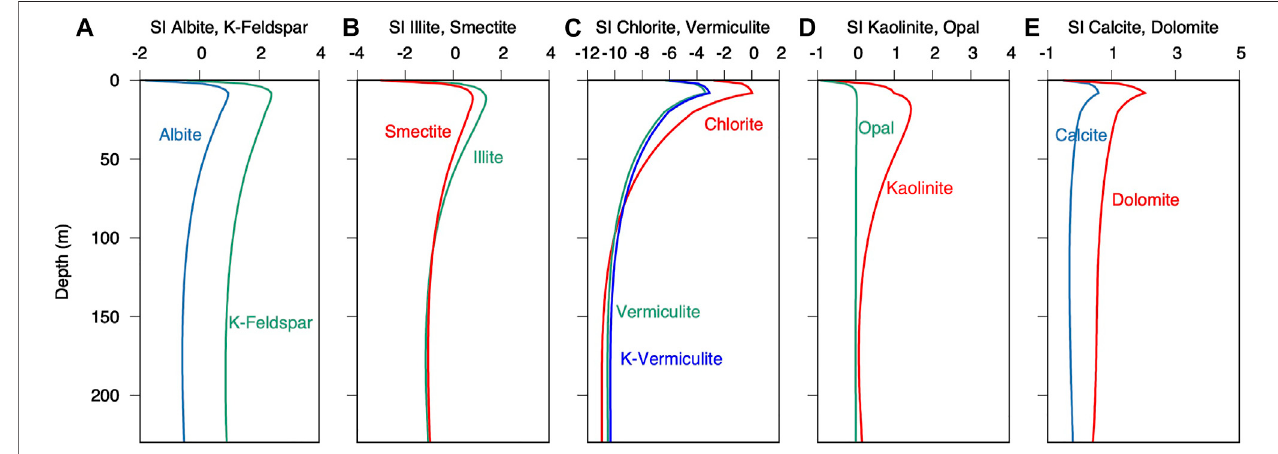
FIGURE 6 | Saturation indices (SI) of silicate minerals (A) albite and K-feldspar, (B) illite and smectite, (C) vermiculite and chlorite, (D) kaolinite and cristobalite, and (E) calcite and dolomite.